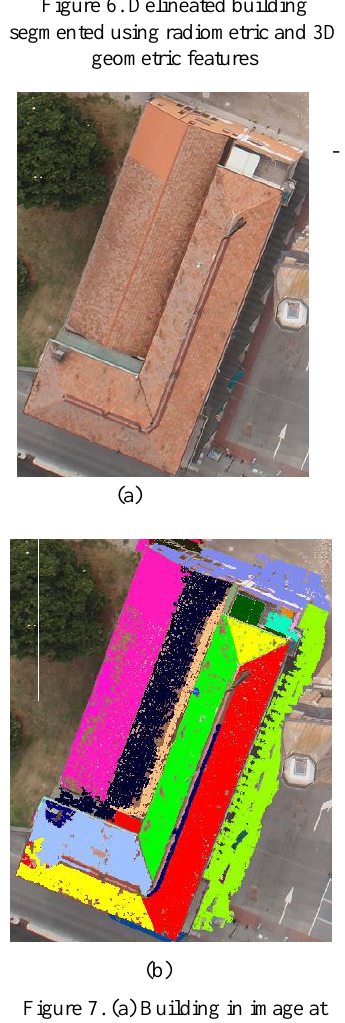
Figure 7. (a) Building in image at smaller scale and different orientation compared to Figure 3, and (b) corresponding